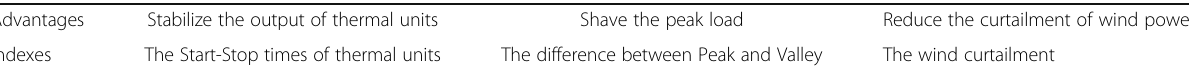
Table 3 The advantages and corresponding indexes of the optimization method